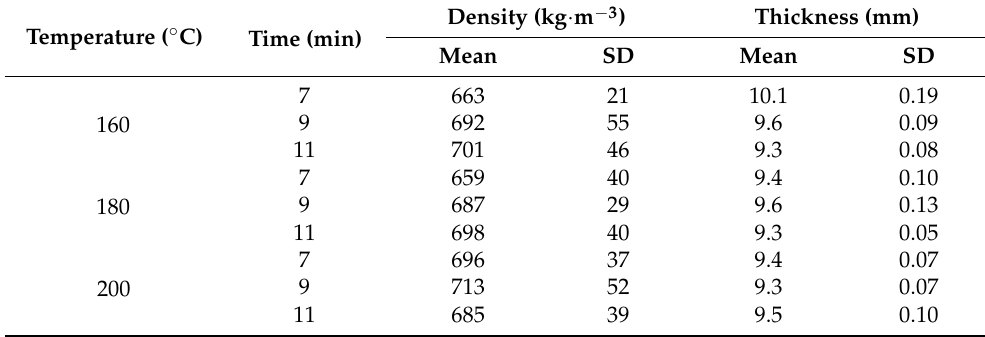
Table 2. Density and thickness values of particleboards glued with 15% tannin in function of the pressing